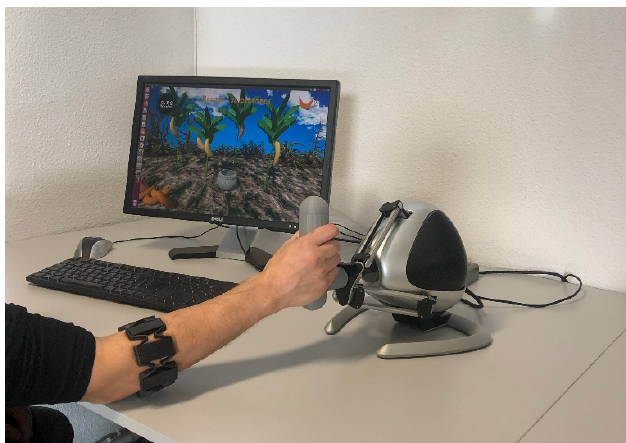
Figure 5. Example of a healthy trial with the Novint Falcon held on the right hand and the Myo